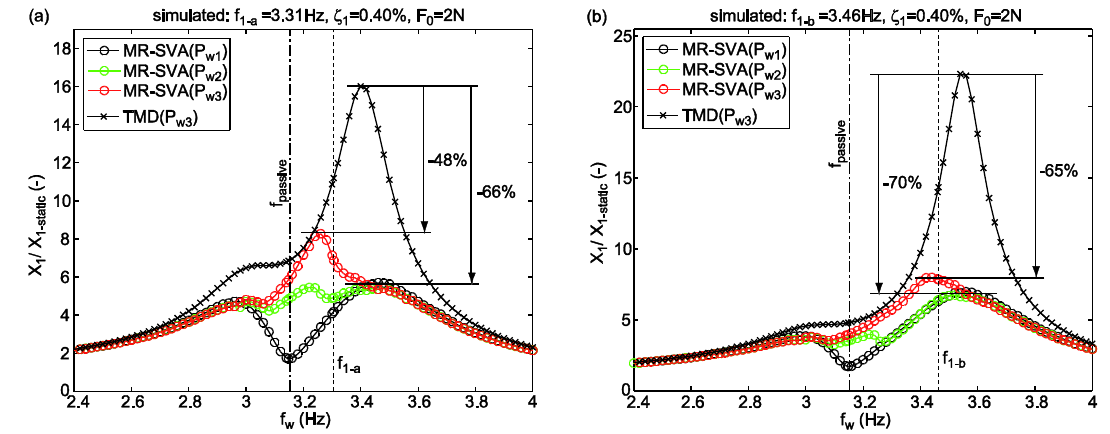
Figure 7. Simulated vibration reductions of lighter primary structures with ( a ) f 1 − a and ( b ) f 1 − b .